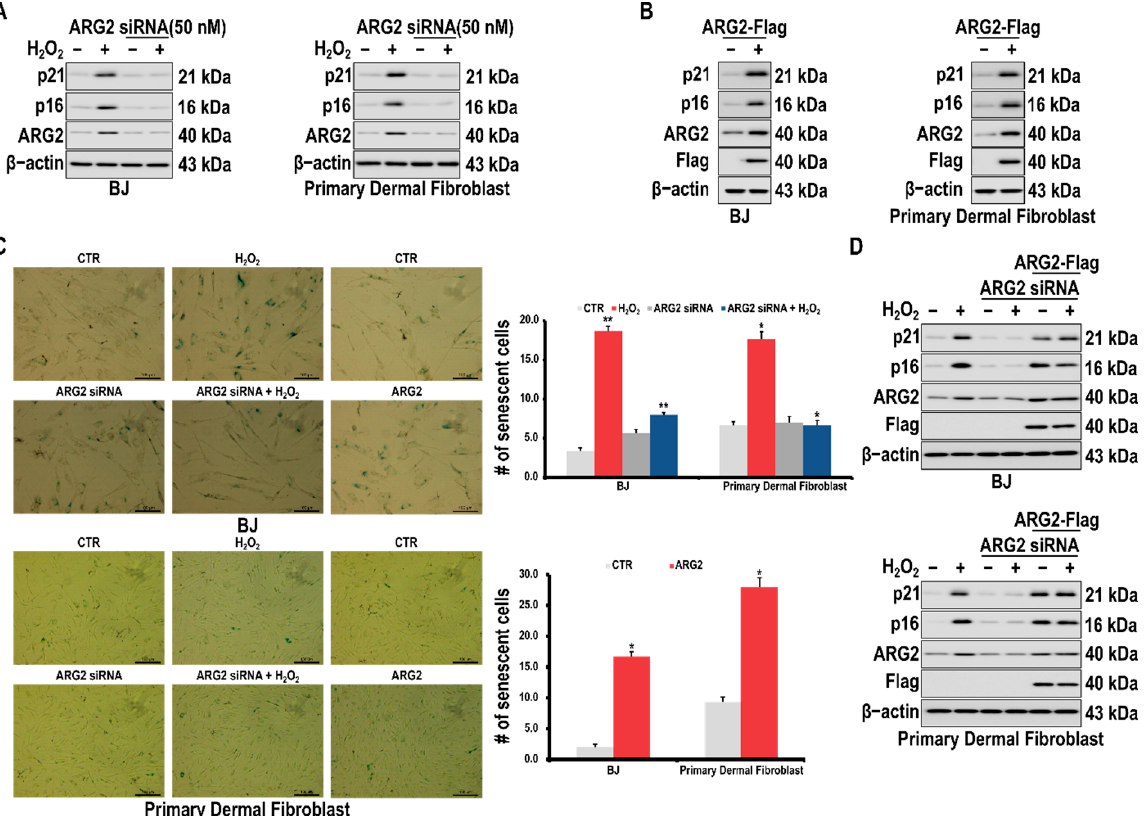
Figure 2. Effects of ARG2 on senescence of skin fibroblast cells. ( A ) Effect of ARG2 knockdown on the expressions of cellular senescence markers, p16 and p21, in skin fibroblasts. Cells were transfected with an ARG2 siRNA and then treated with H 2 O 2 (200 μ M) for 24 h. ( B ) Effect of ARG2 overexpression on the expressions of the cellular senescence markers, p16 and p21, in skin fibroblasts. Cells were transfected with a plasmid containing a flag-tagged ARG2. ( C ) Representative images of H 2 O 2 -treated skin fibroblasts stained for senescence-associated β -galactosidase after being transfected with an ARG2 siRNA (left) or an ARG2 overexpression plasmid (right). # represents the number of senescent cells. ( D ) Effect of restoring ARG2 levels on senescence of skin fibroblasts. Cells were transfected with an ARG2 siRNA, treated with H 2 O 2 for 24 h, and then transfected with a flag-tagged ARG2 plasmid. Protein levels were determined using Western blotting. A * p value < 0.05 and ** p value < 0.01 were considered statistically significant and error bars represent ± SD.